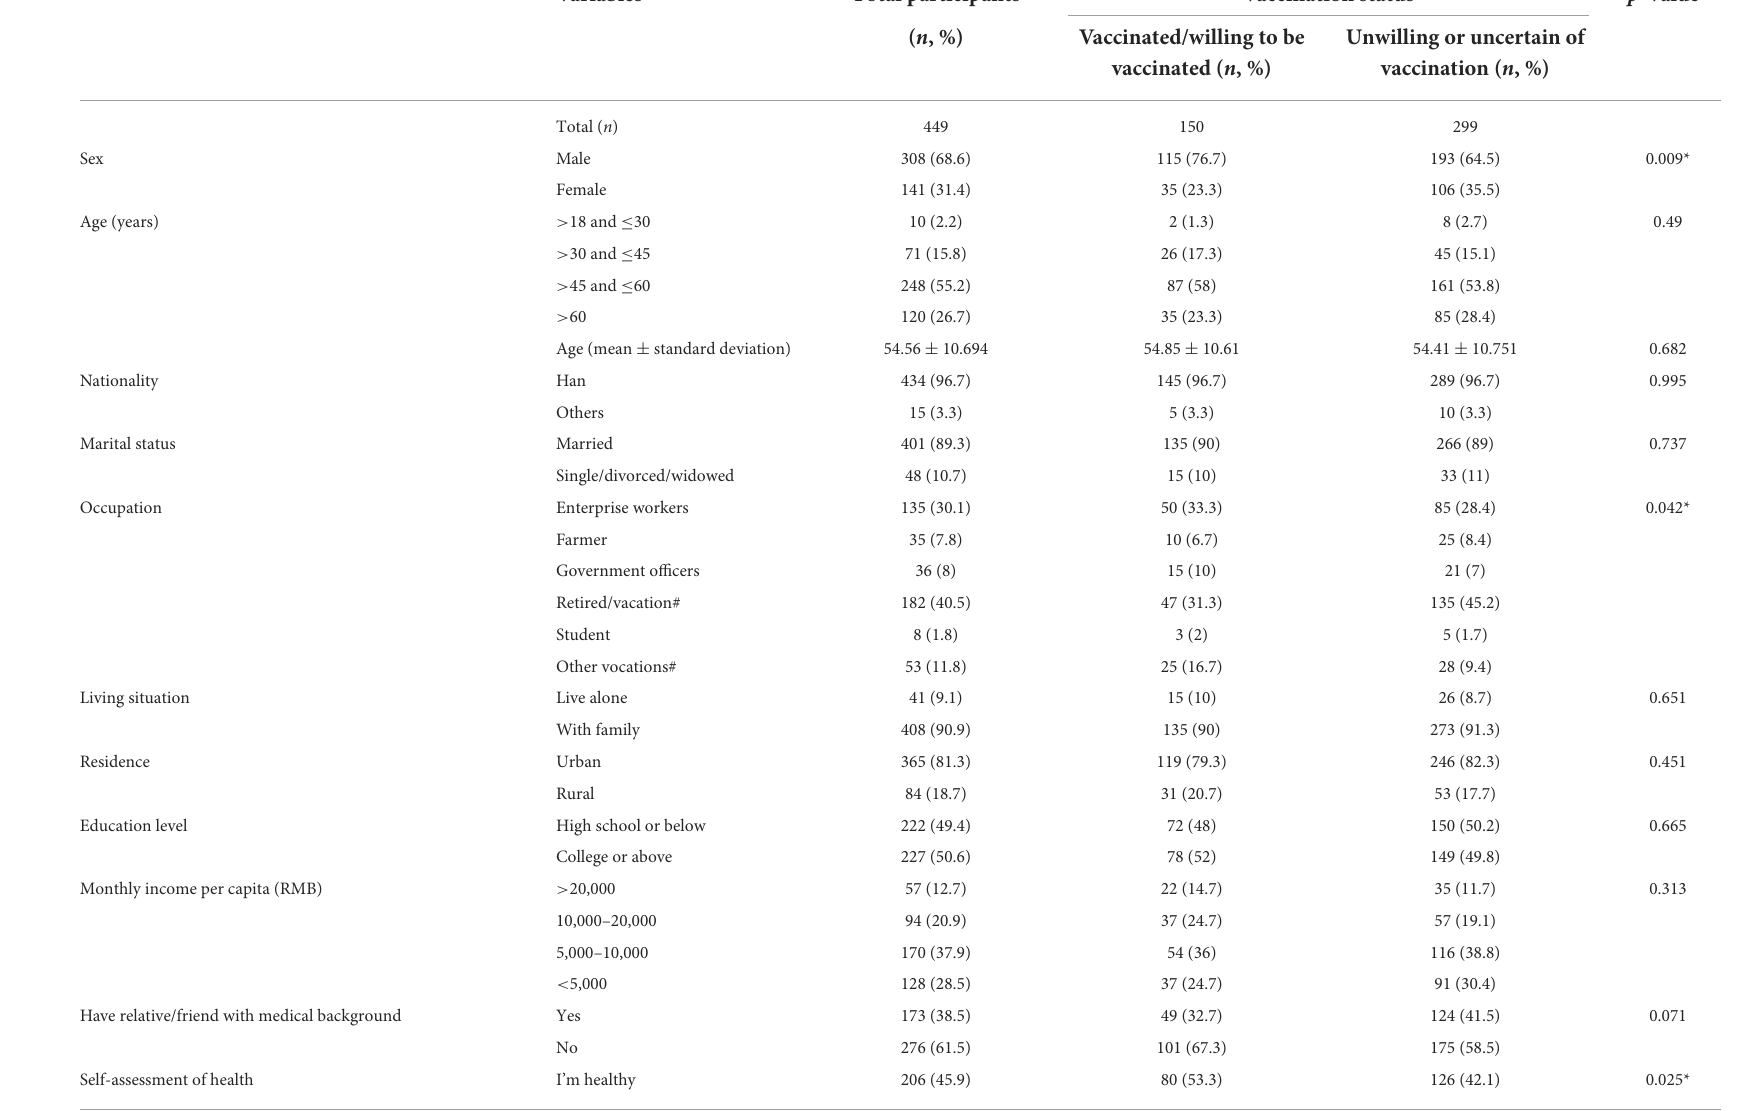
TABLE 1 Demographic data and sample characteristics of participants.